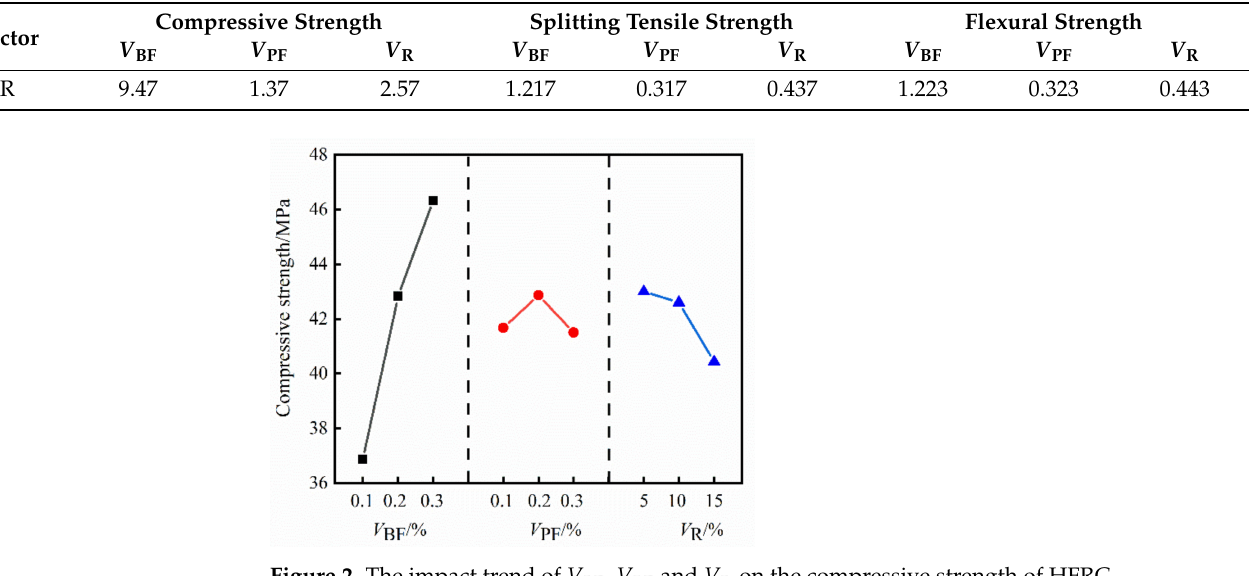
Figure 2. The impact trend of V BF , V PF and V R on the compressive strength of HFRC.